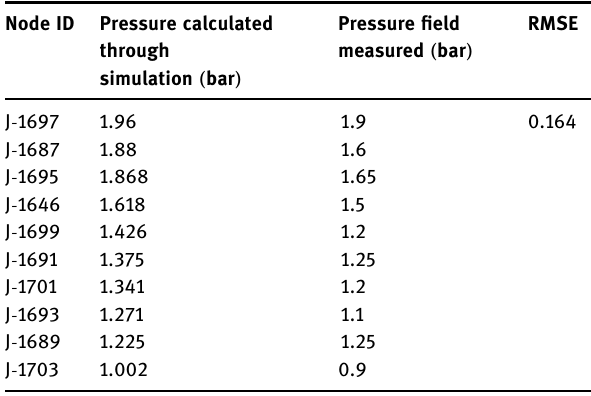
Table 1: Comparison between calculated and measured